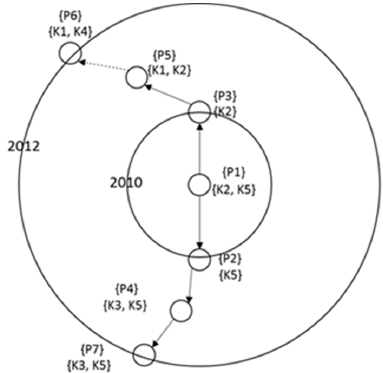
Figure 7. Concept diagram for mapping patent evolution.